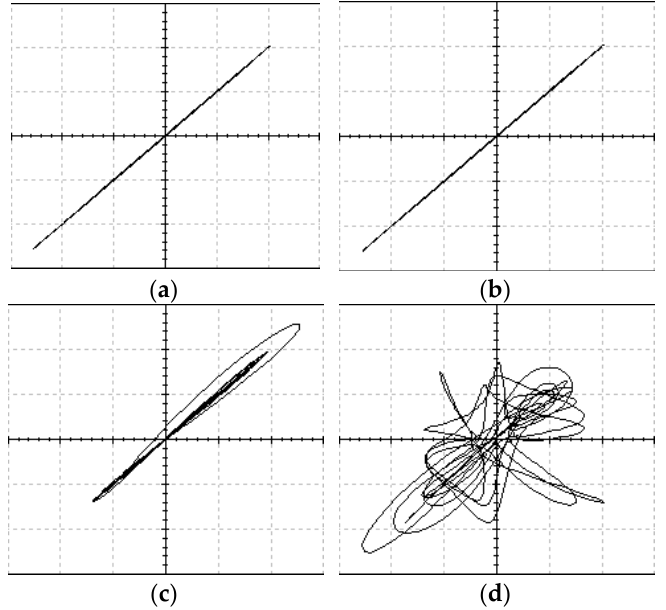
Figure 14. Synchronous effects with different control gains. ( a ) q = 10 (1 V/div, 1 V/div); ( b ) q = 3.3 (1 V/div, 1 V/div); ( c ) q = 2 (1 V/div, 1 V/div); ( d ) q = 1.4 (1 V/div, 1 V/div).